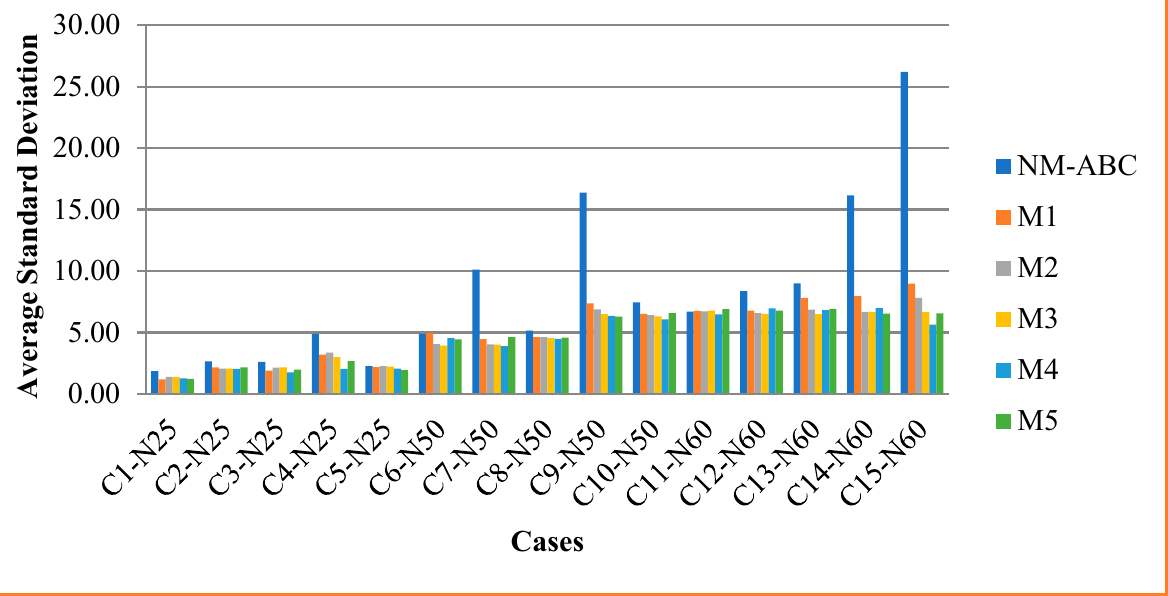
Figure 4. Analysis and Comparison of Average Standard Deviation.